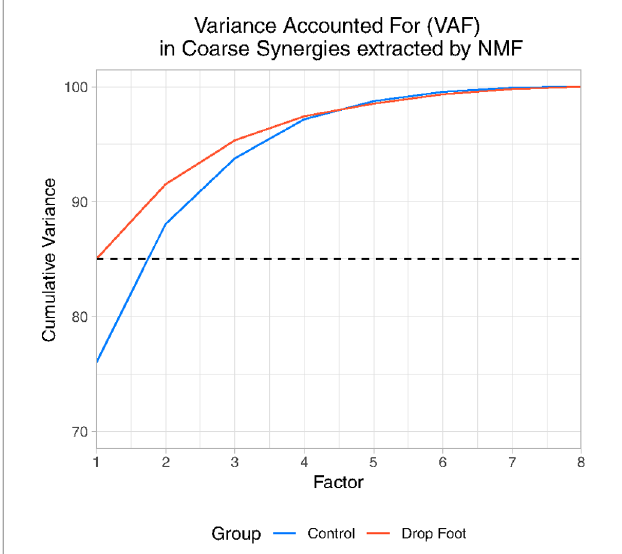
FIGURE 1 Cumulative variance accounted for each Factor extracted by NMF in drop foot (DF) and Control